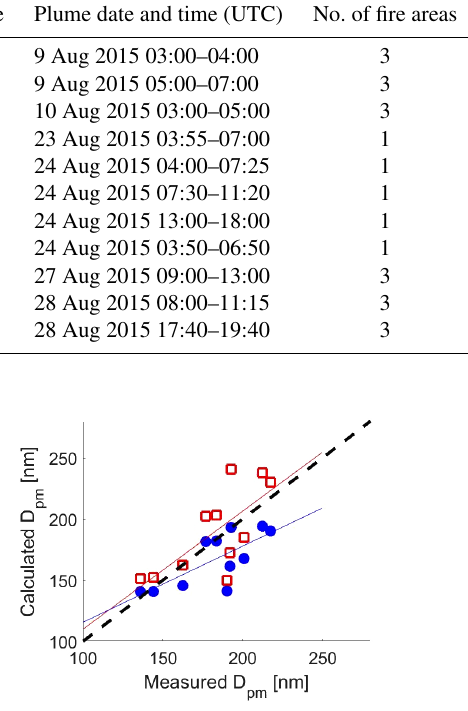
Figure 12. Scatterplot showing calculated and measured D pm for biomass-burning plumes observed at MBO in August 2015. The blue circles represent D pm calculated using Eq. (1) (d M/ d x ), and the red circles represent D pm calculated using Eq. (2) (d M/ d x d z ).